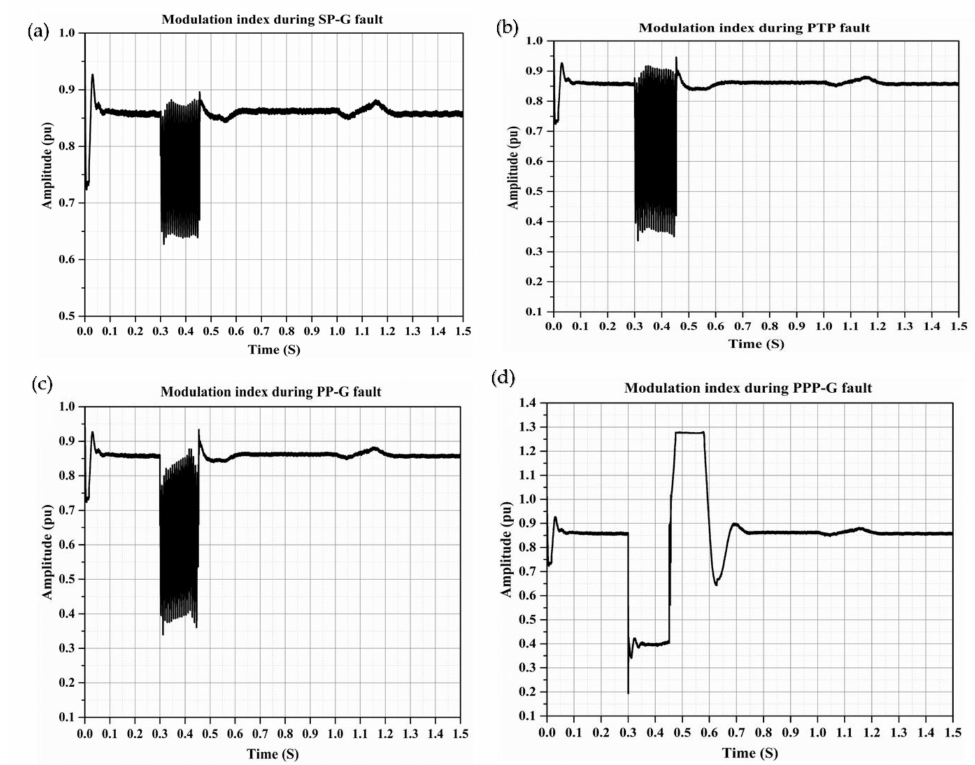
Figure 9. ( a – d ) The modulation index of Uabc_ref used by the pulse-width modulation (PWM) generator of the voltage source control